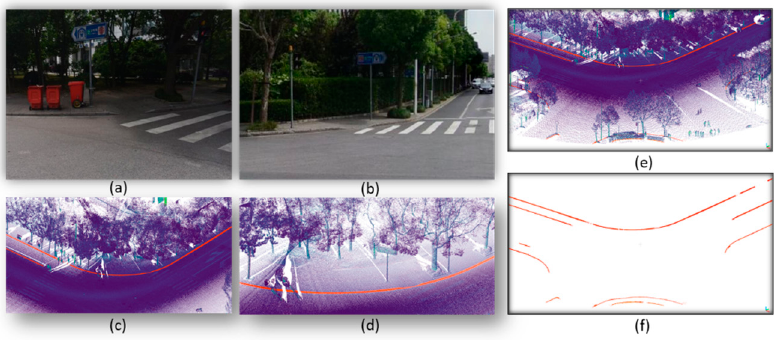
Figure 15. Extraction results of curved curbs. ( a , b ) Two detail views of study sites; ( c – e ) Point cloud of the studied area overlapped by segmented curbs; ( f ) The result of curb extraction by proposed method.